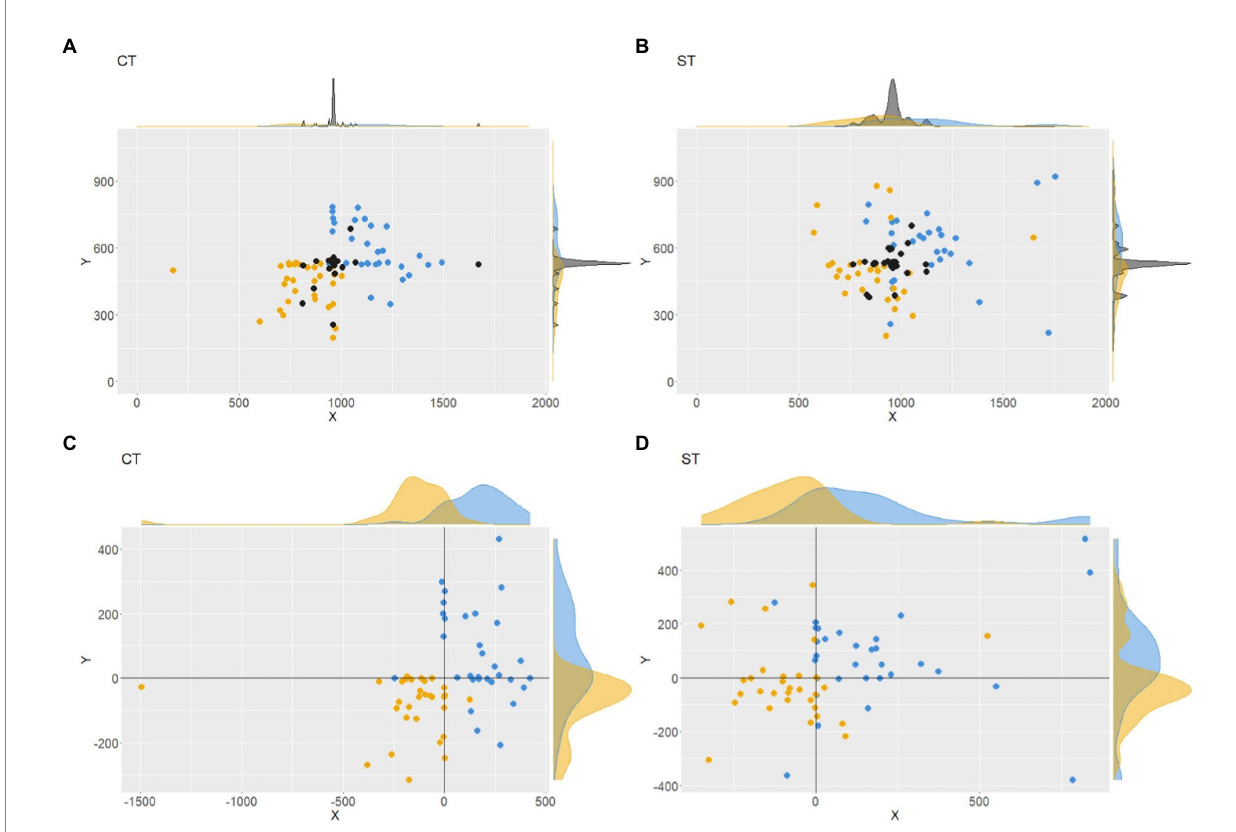
FIGURE 4 Absolute positions of circles in CT (A) and ST (B) . Each yellow, black, and blue dot expresses the past, present, or future position of a participant. The same results are plotted as positions relative to the present circle/sphere of the same participant for CT (C) and ST (D) .